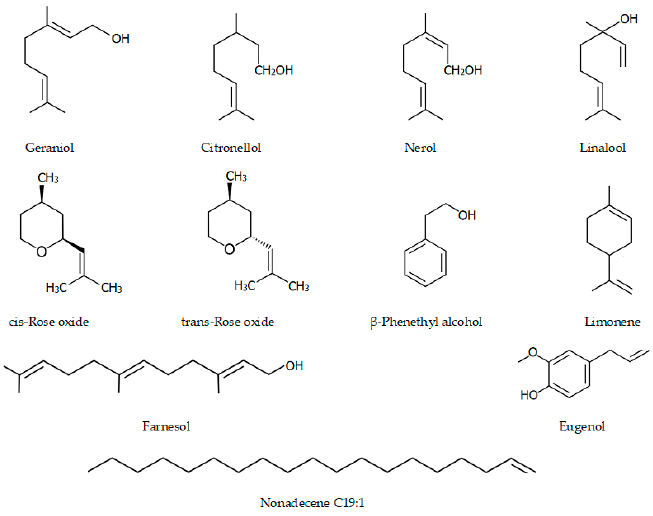
Figure 2. Main compounds in the chemical composition of rose extracts.